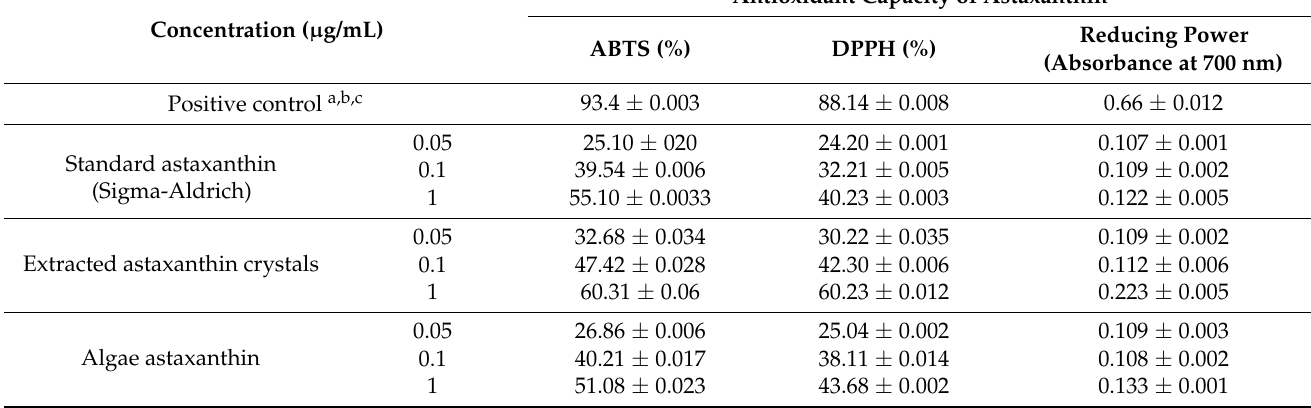
Table 1. ABTS, reducing power, and DPPH were used to test the ROS reduce abilities in various astax- anthin. Three types of astaxanthin: Sigma-Aldrich Co., Burlington, MA, USA; extracted astaxanthin; and